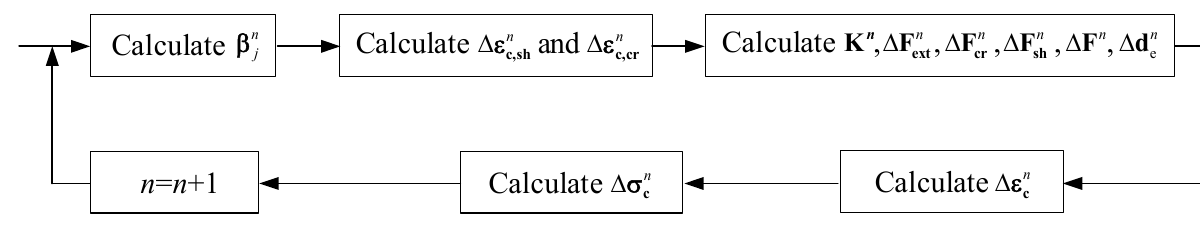
Figure 3. Synoptic scheme of inputted geometric and mechanical parameters.